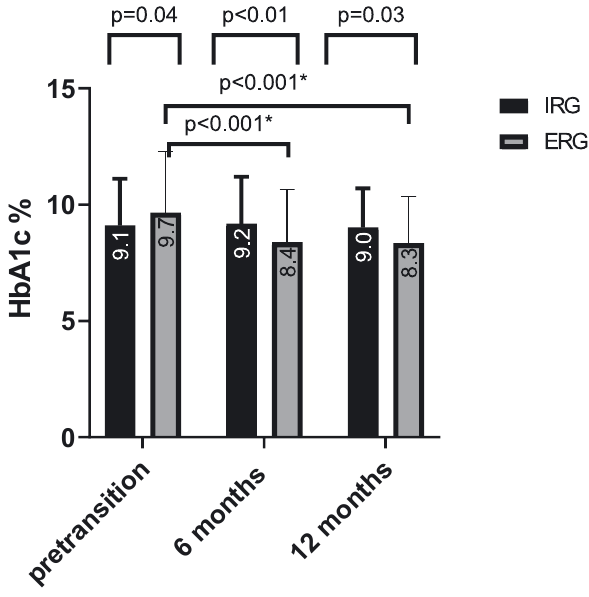
Figure 1: Graphical representation of mean HbA 1c between referral sources.